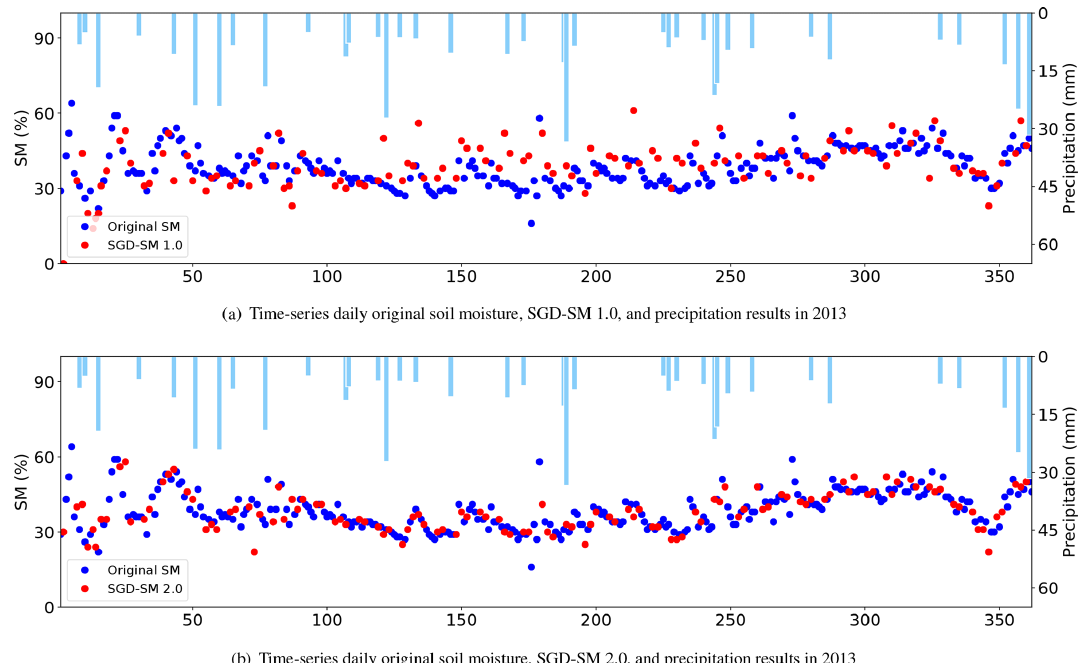
Figure 11. Time-series daily original soil moisture, SGD-SM 1.0/2.0, and precipitation results at location (48.875 ◦ N, 140.375 ◦ E) in